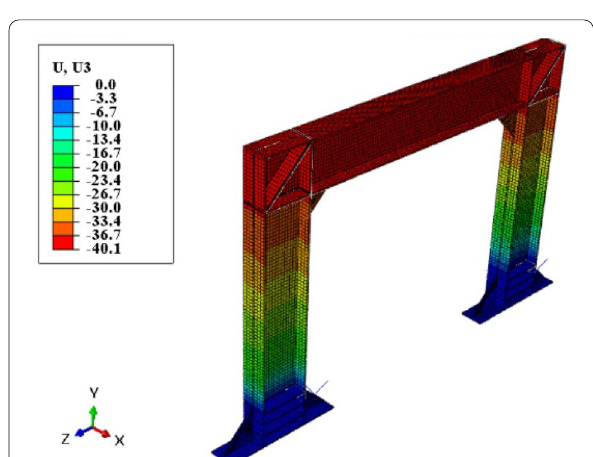
Fig. 23 Maximum sway displacement of ABAQUS frame (units in mm).